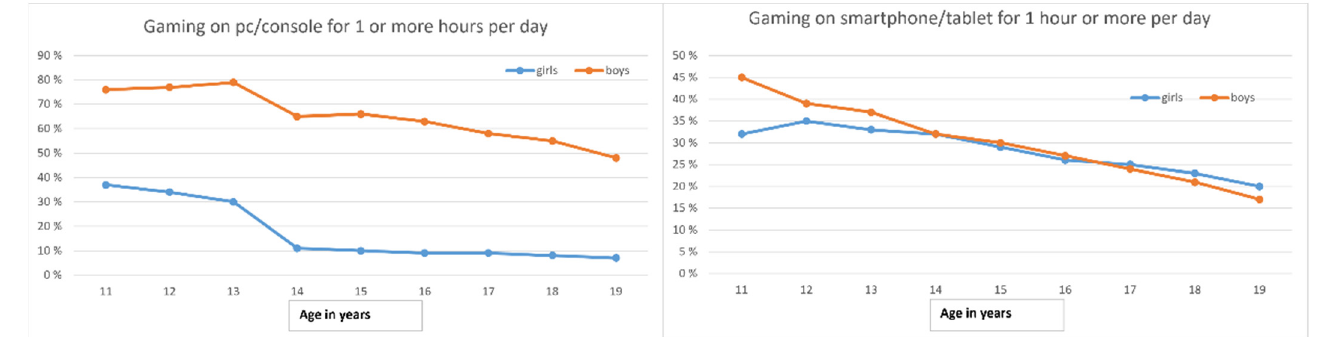
Figure 2. On the left: Percentage of students gaming on PC/console one hour or more per day, by age and gender. On the right: Percentage of students gaming on smartphone/tablet one hour or more per day, by age and gender. Gender differences are significant with a p -value of <0.001 in all age groups.